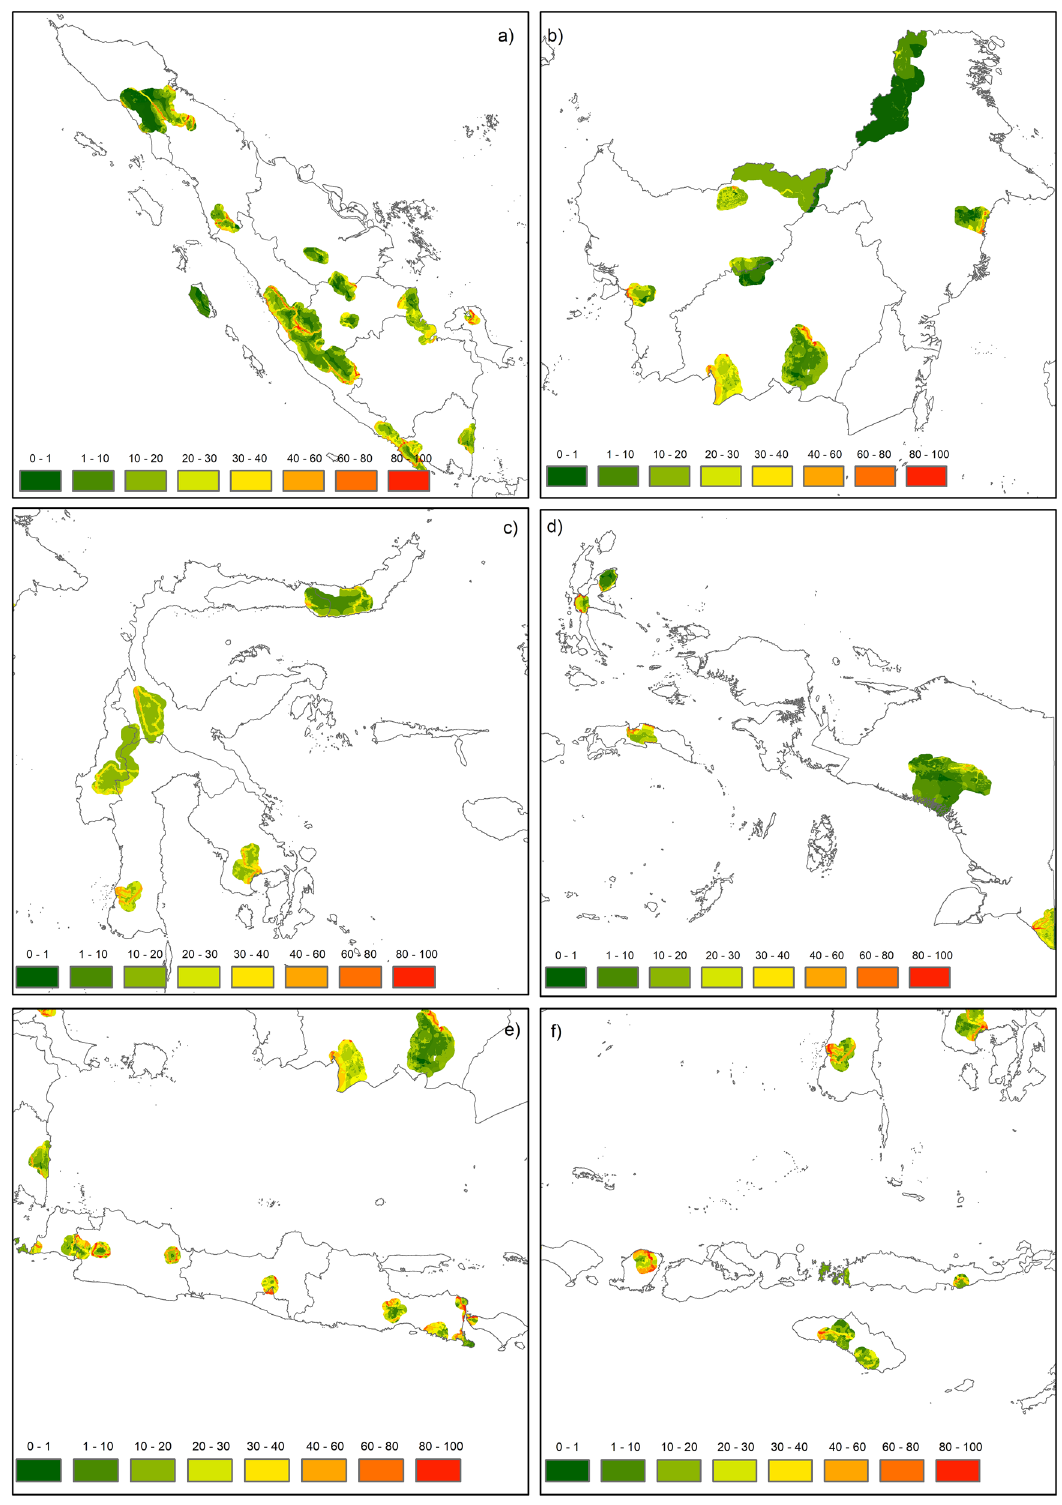
Figure 1. Human Footprint in 2017 within and around 43 terrestrial national parks (NPs) in 7 bioregions in Indonesia: ( a ) Sumatra, ( b ) Kalimantan, ( c ) Sulawesi, ( d ) Maluku and Papua, ( e ) Jawa and Bali, and ( f ) Nusa Tenggara. Activity data maps of Indonesian NPs (land cover maps, roads, river and settlements) used in the Human Footprint analysis in this study were obtained from the Indonesian Ministry of Environment and Forestry 32 , and Binamarga 33 . National Parks boundaries were obtained from The World Database on Protected Areas (https ://www.prote ctedp lanet .net/en). The Human Footprint maps were created using Esri ArcMap 10.8 (https ://www.arcgi